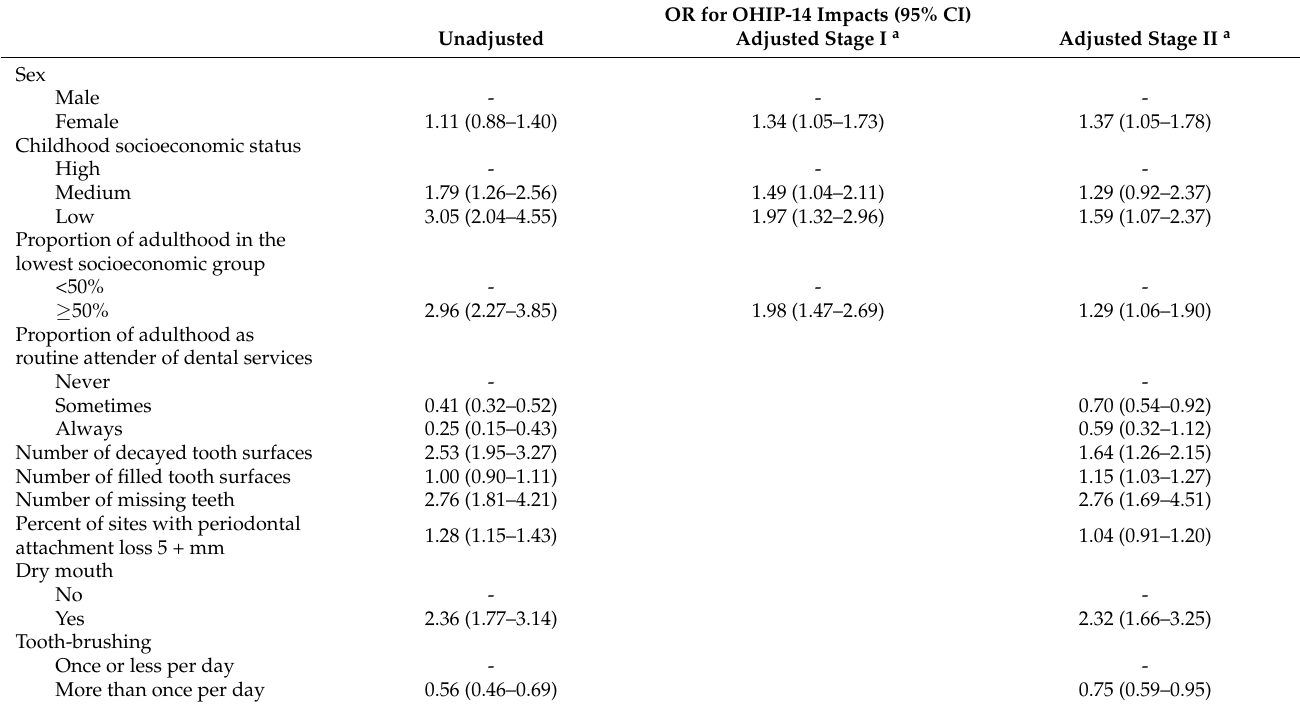
Table 5. Generalised estimating equation model for oral health impact profile (OHIP-14) impact prevalence from age 32 to 45